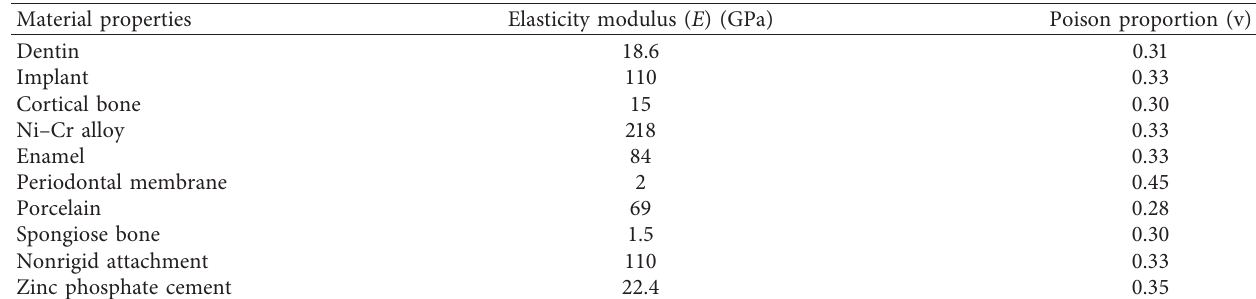
Figure 2: 3D FEA models. Table 1: Materials’ elasticity modulus ( E ) and Poisson’s ratio ( v